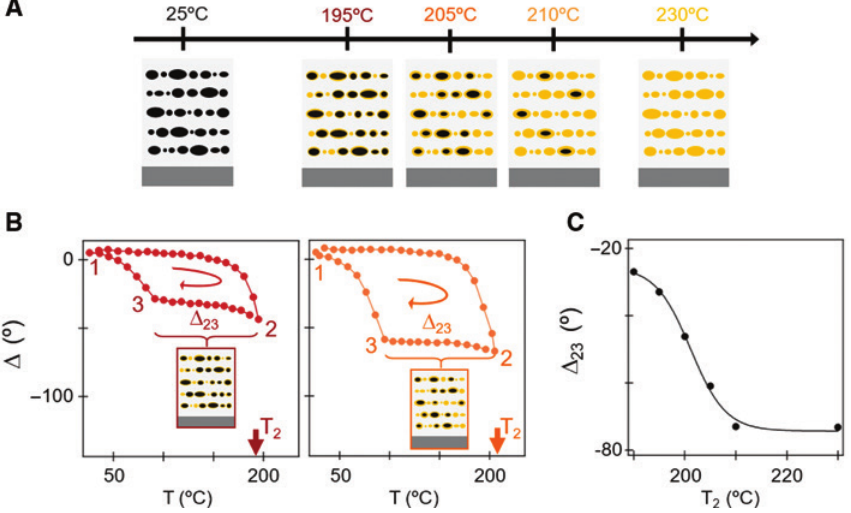
Figure 4: The analog, reversible and hysteretic character of the phase tuning. (A) The proposed microscopic origin for the analog character of the phase tuning. The Bi melting point is size-dependent and size- dependent surface melting occurs; hence, a controlled fraction of the polydisperse Bi nanostructures can be melted by heating the PCM to a given temperature. At 25 ° C, 100% of the nanostructures are solid (black). At 230 ° C, 100% are liquid (orange). (B) The Δ = f(T) = 195 ° C; Right curves for the PCM recorded continuously when heating to a temperature T and then cooling to 25 ° C. Left panel: T 2 2 = 205 ° C. These curves show the reversibility and hysteretic character of the phase tuning. The Bi melted at point 2 remains in panel: T 2 a liquid state when decreasing the temperature to point 3 (undercooling). This leaves Δ almost unchanged near a value Δ over a broad 23 temperature range ( ~ 100 ° C). Δ is defined as the Δ value midway from T to T on the hysteresis. (C) Such a stable value of Δ can be 23 2 3 23 tuned in an analog manner by controlling the fraction of melted Bi, i.e. by properly choosing T . All the data in this figure were recorded 2 for E = 2.3 eV and AOI = 64.5 °